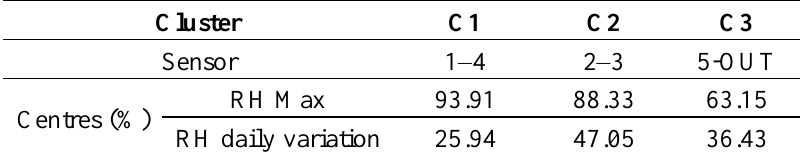
Table 1. Results of cluster analysis for data recorded before installing the expanded clay and geotextile (from 25 July 2013 to 12 August 2013, from 00.00 to 23.59 h; 864 data points/sensor).